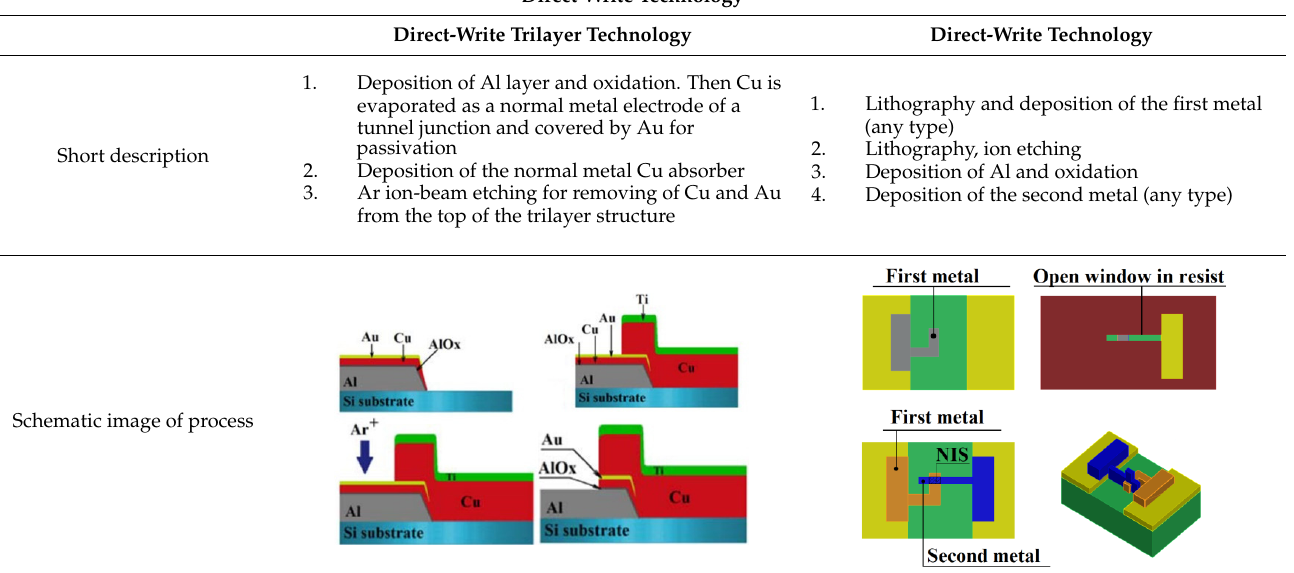
Table 3. Comparison of different direct-write technologies for the fabrication of tunnel junctions.